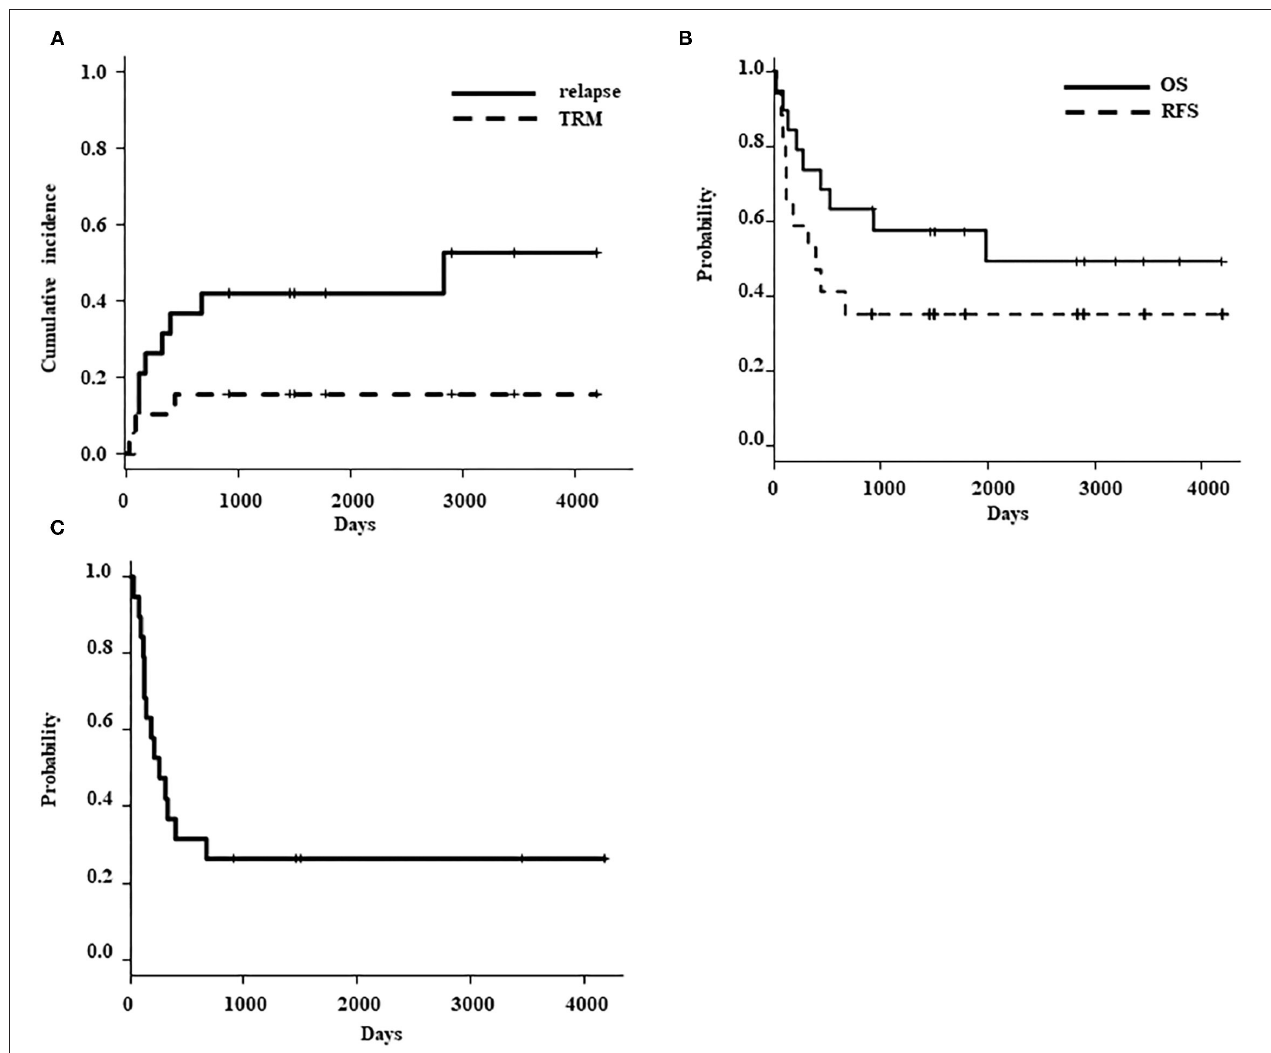
FIGURE 2 | (A) Cumulative incidence of relapse (solid line) and transplant-related mortality (dotted line). (B) Probability of overall survival (solid line) and relapse-free survival (dotted line). (C) Probability of moderate-severe chronic GVHD/ relapse free survival (CGRFS).